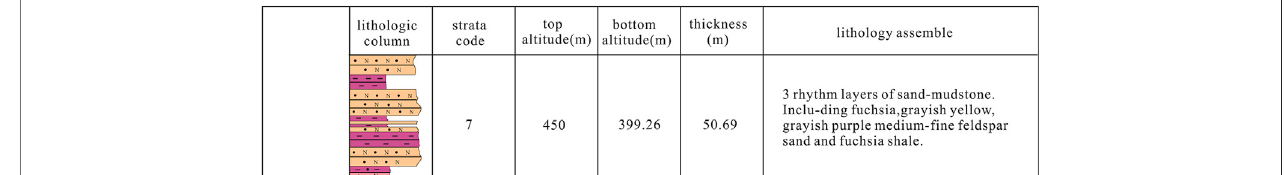
Frontiers in Earth Science |